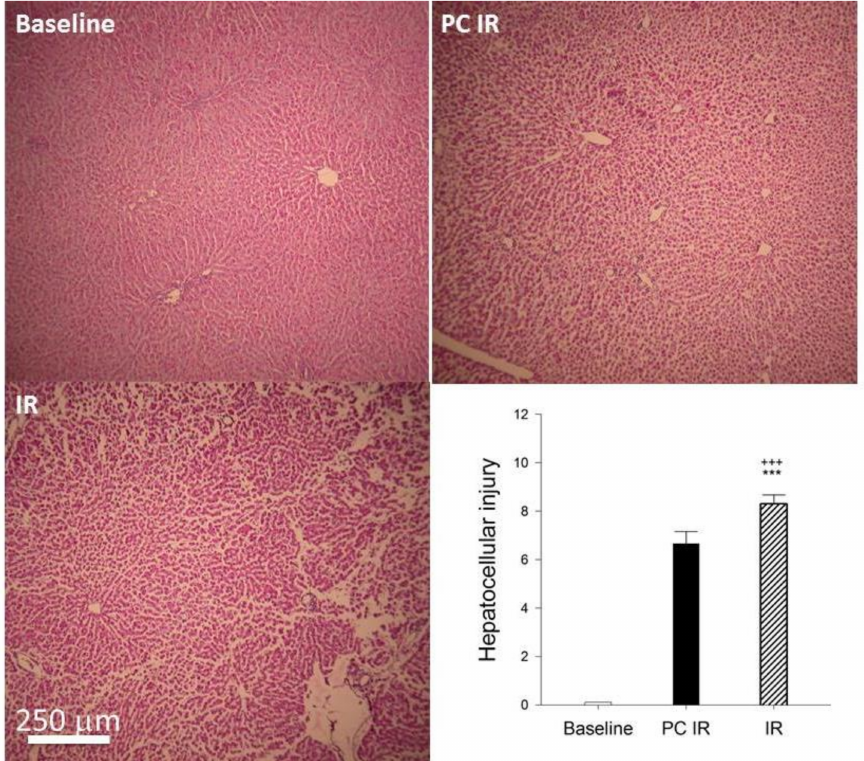
Figure 5. Histology hematoxylin-eosin staining. Photomicrographs at 10 × magnification. Baseline: Fresh resected livers; PC IR: livers were preconditioned with hypothermic perfusion (22 ◦ C) for 10 min and 10 min of normothermia previous to 40 min of ischemia and 20 min of reperfusion. IR: livers were perfused at normothermia, 37 ◦ C for 20 min and then submitted to 40 min of ischemia and 20 min of reperfusion. Liver sections were stained with hematoxylin and eosin according to standard procedures. Scale bar, 250 µ m. Tissue injury was scored as described in the Material and Methods section. Significantly different from corresponding Baseline values: +++ p < 0.001. Significantly different from corresponding PC IR values: *** p <